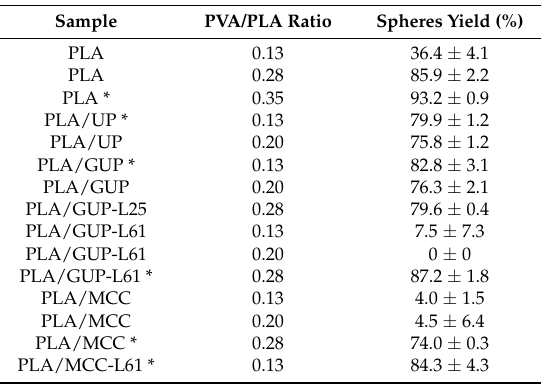
Figure 2. Pictures of some PLA/cellulose biocomposite spheres: ( a ) PLA/MCC; ( b ) PLA/MCC-L61; ( c ) PLA/GUP; ( d ) PLA/GUP-L61 (see Table 1 for sample identification). Table 1. Effect of PVA/PLA ratio on PLA/cellulose spheres yield, for different samples (cellulose can be UP: unbleached pulp, GUP—grinded UP, GUP-L25—GUP with 25 wt % lignin, GUP-L61—GUP with 61 wt % lignin, MCC—microcrystalline cellulose, MCC-L61—MCC with 61 wt %